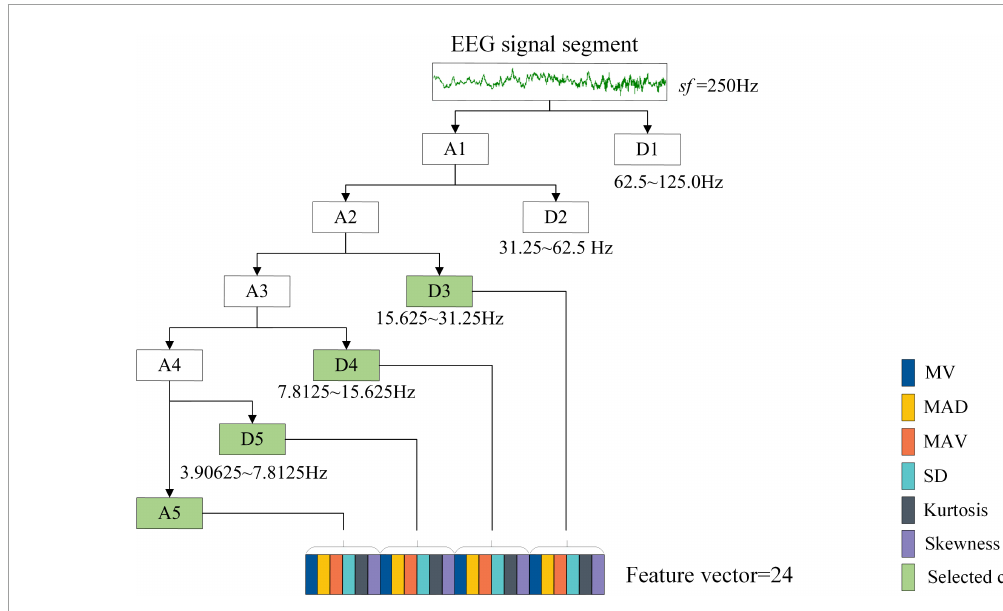
FIGURE6 Discrete wavelet transform feature extraction from the raw EEG